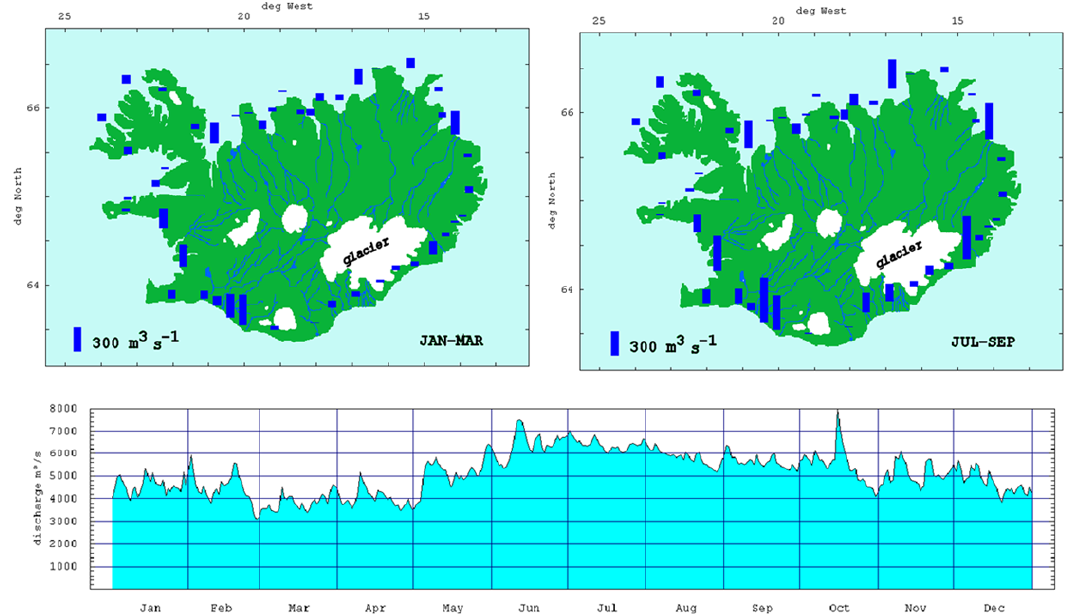
Fig. 3. Winter (left panel) and summer (right panel) mean discharge of 46 Icelandic watersheds for the time period 1992 to 2006 simulated with WaSiM. Below the simulated mean seasonal signal of the island’s overall discharge for the same time period is shown.